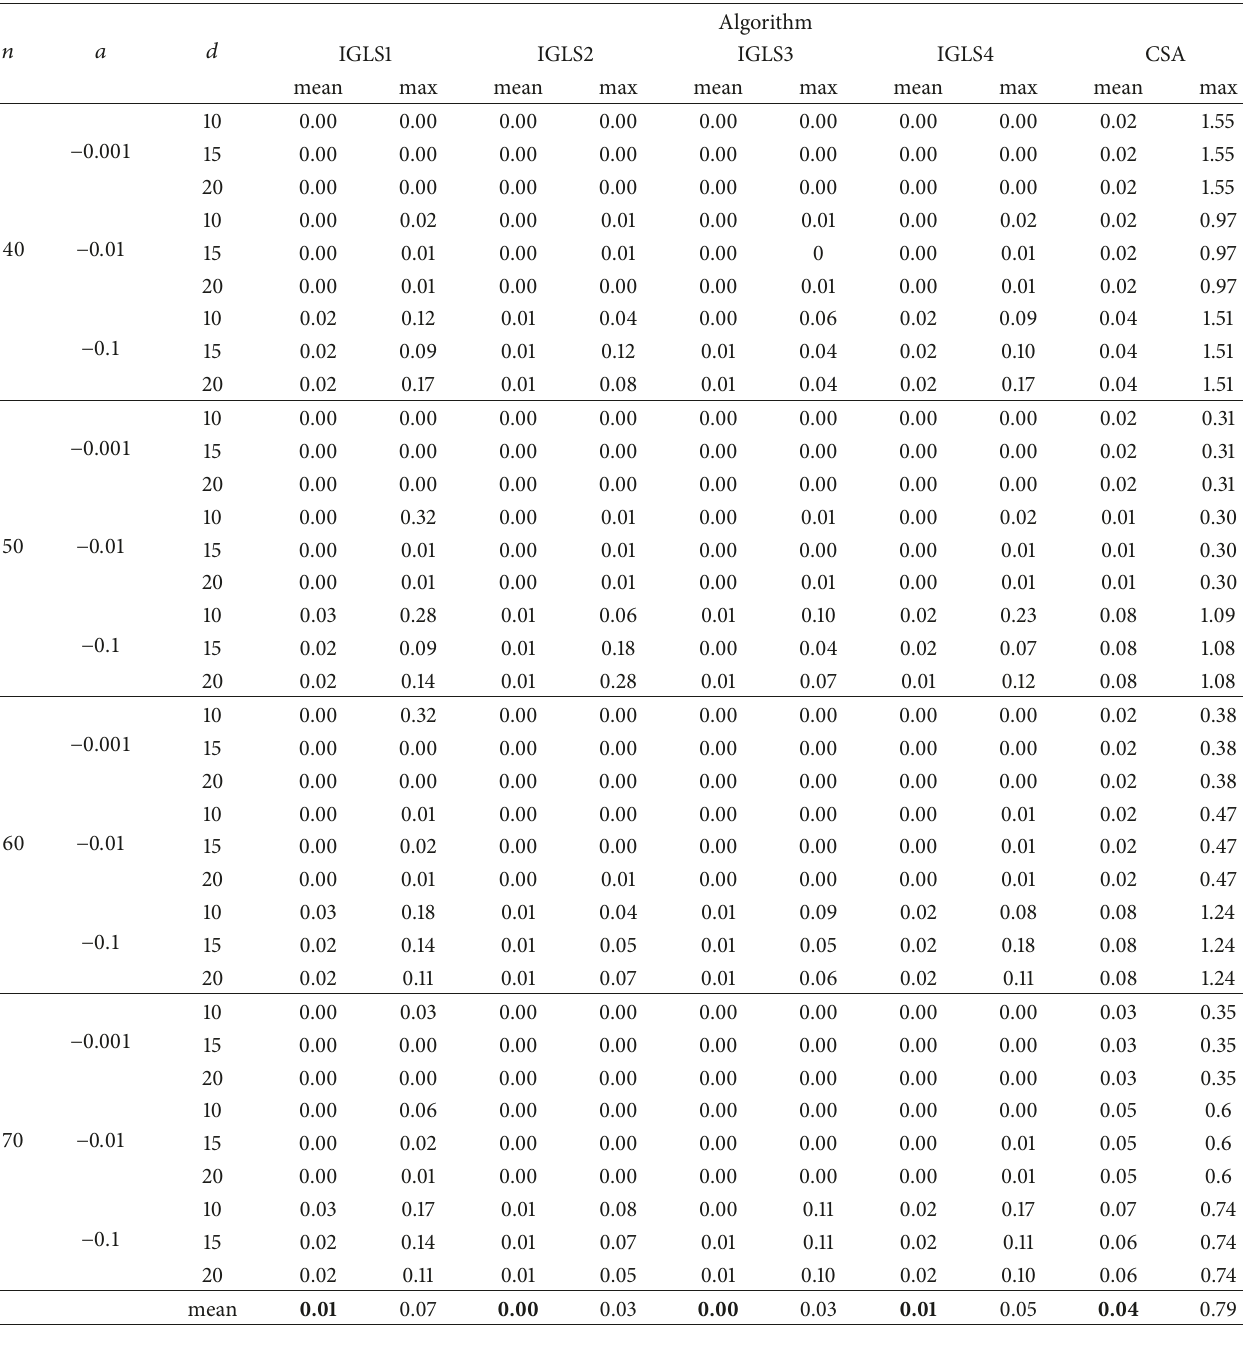
Table 6: The RPD of five algorithms for large number of